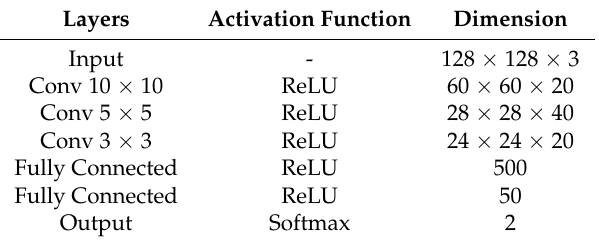
Table 1. The structure of the convolutional neural network (CNN)-health stage